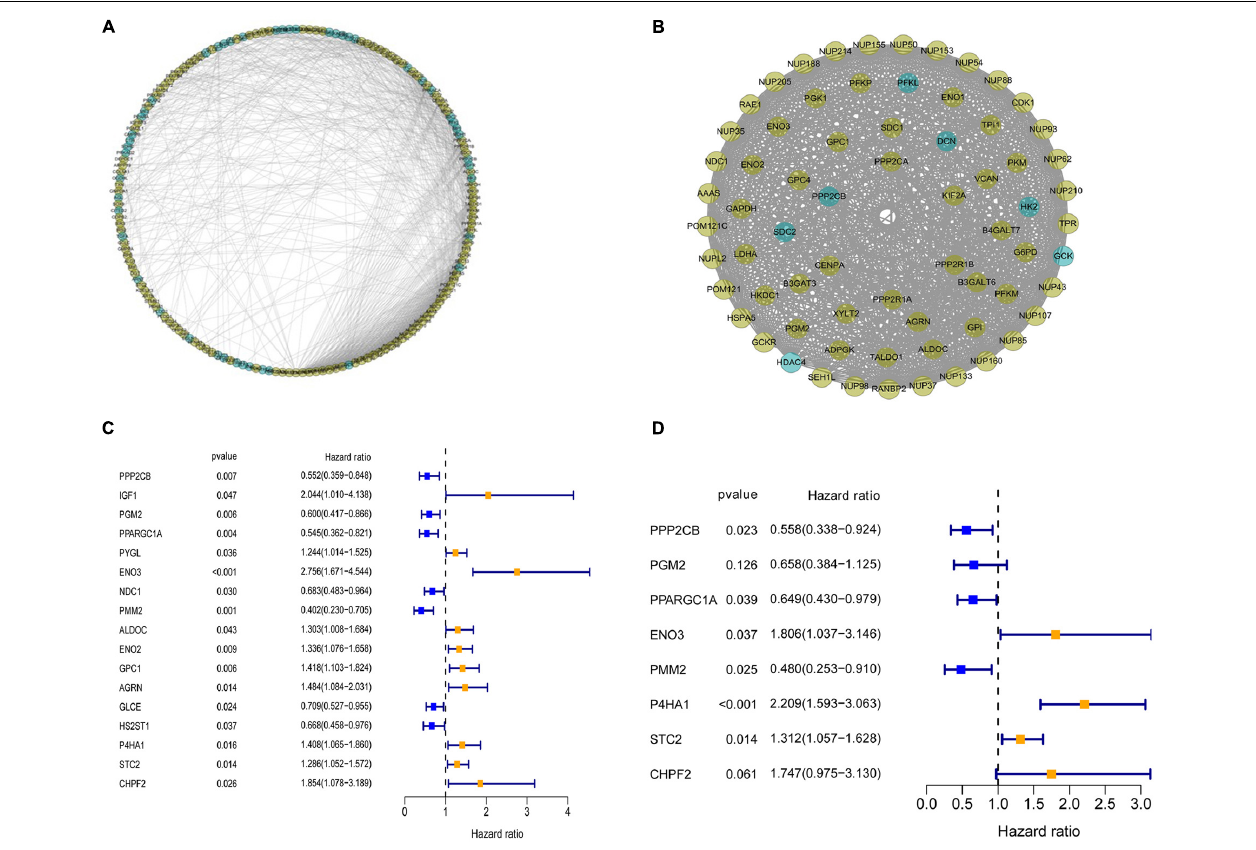
FIGURE 3 | Protein–protein interaction (PPI) network construction and selection of prognosis–related glycolysis-related genes (GRGs). (A) PPI network of differential GRGs (DE-GRGs). (B) Critical module constructed from PPI network. Green circles indicate downregulation with more than two-fold change. Yellow circles indicate upregulation with more than two-fold change. (C) Univariate Cox regression analysis with preliminary identified prognostic related GRGs. (D) Multivariate Cox regression analysis with prognosis-related GRGs.